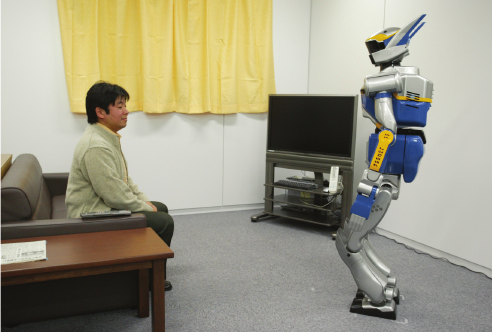
Figure 7: HRP-2 during a HumanAID task.